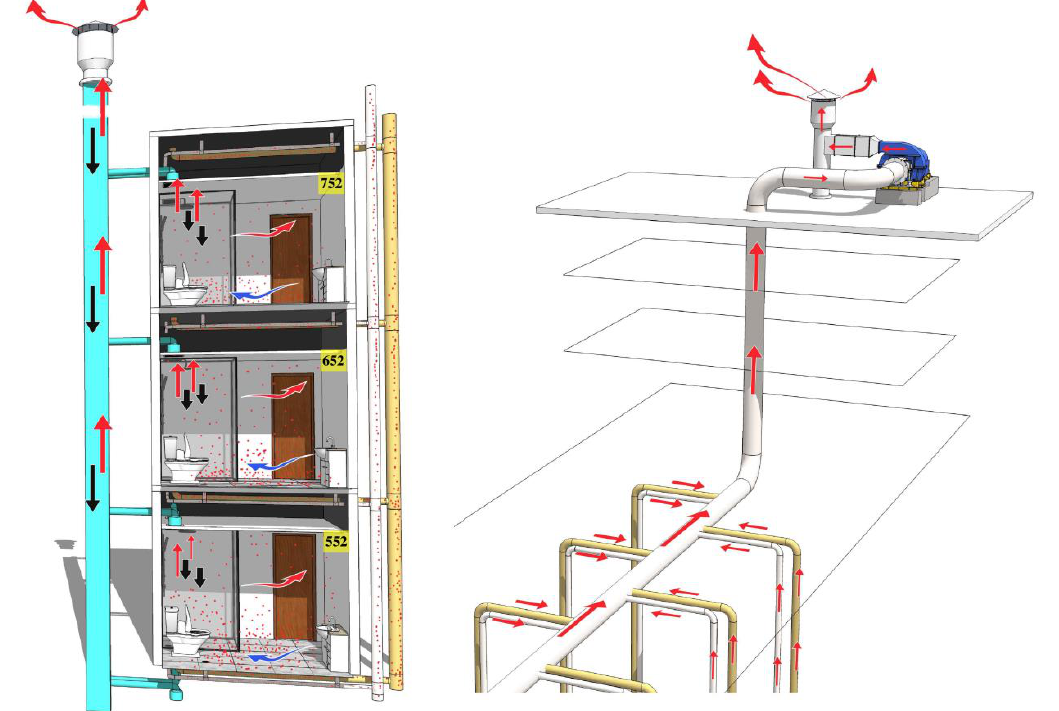
Figure 2. The schematic diagrams of vertical transmission in bathrooms and pipeline convergence. Yellow pipes indicate sewage pipes, white pipes indicate drainage pipes, blue pipes indicate exhaust pipes, and red dots indicate simulated viral aerosols.